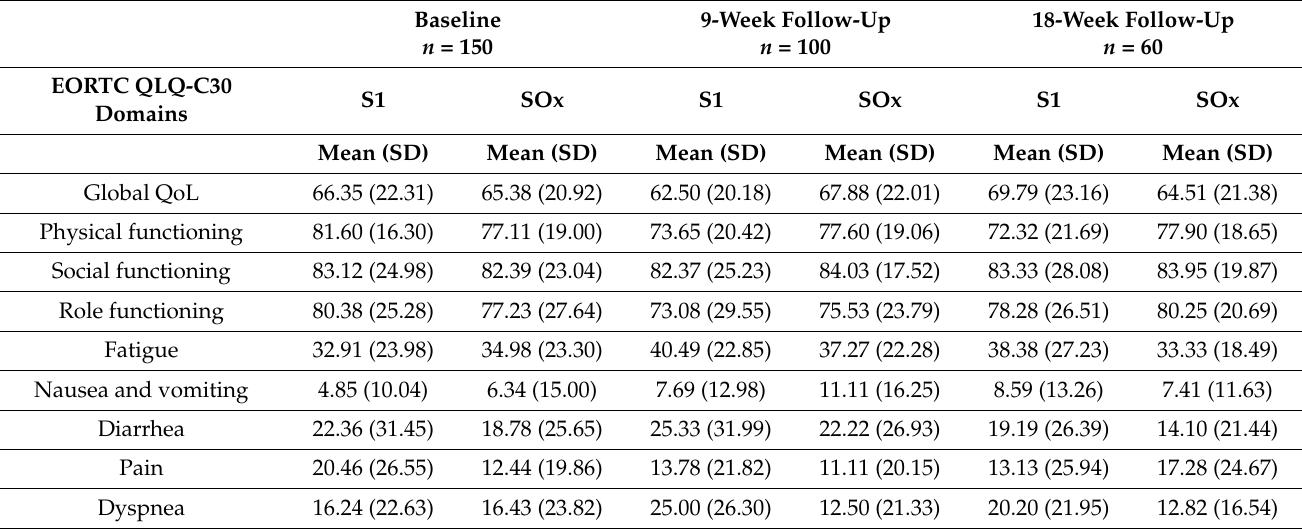
Table 2. Mean values of the European Organization of Research and Treatment of Cancer QLQ-C30 scores per domains by treatment group and time points. The selected domains are of special interest in older patient with mCRC. No statistically significant differences were observed between treatment arms at